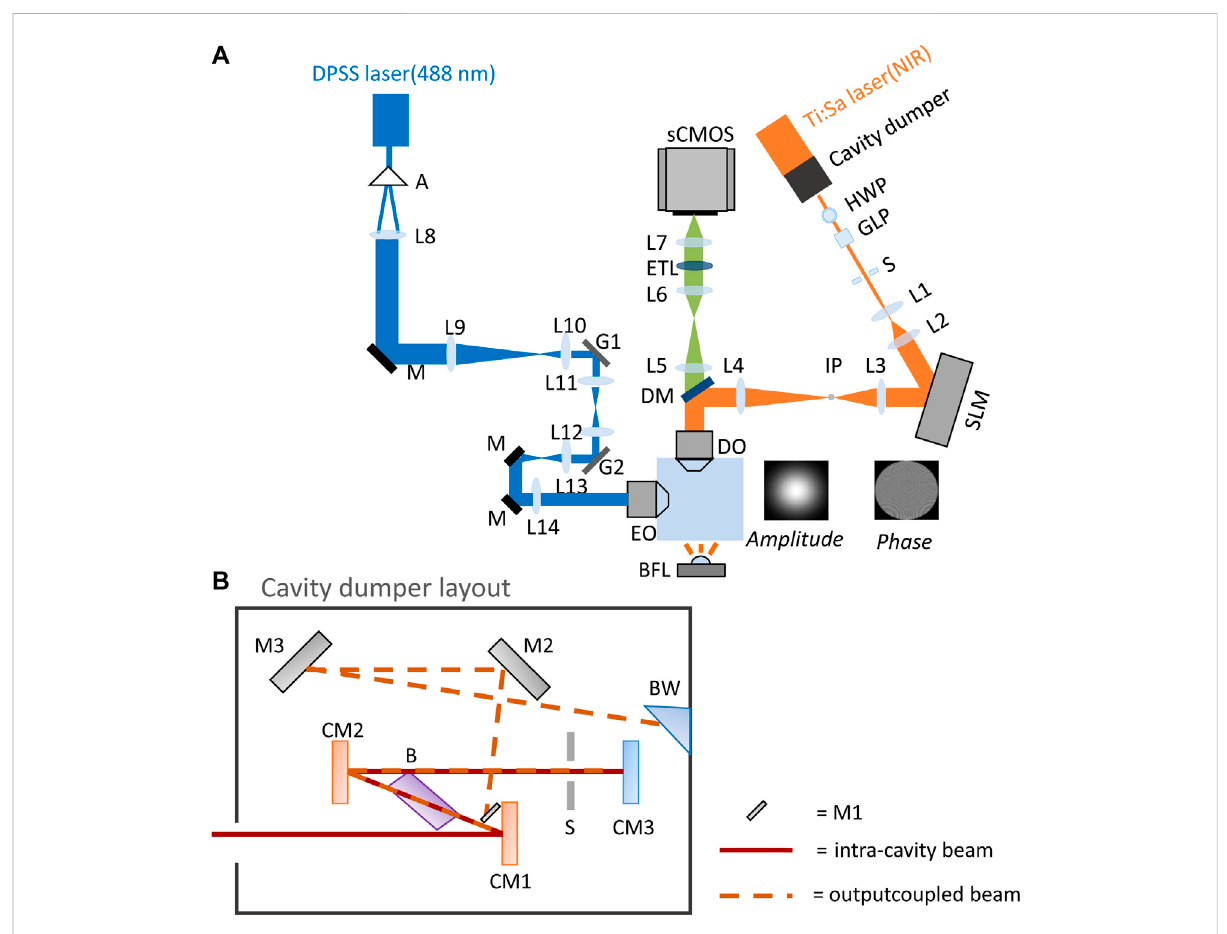
FIGURE 1 Optical setup. (A) Optical layout of the 2P-CGH module coupled to a light sheet microscope. Blue path: light sheet microscope; orange path: 2P-CGH module; green path: common fl uorescence detection path. Not to scale. (B) Cavity dumping layout, not to scale. Red line: intra-cavity beam, dashed orange line: dumped beam. The intra-cavity beam is focused by the focusing mirror (CM1) into the Bragg cell (B) placed at Brewster ’ s angle.TheRFpulseappliedtotheBraggcellde fl ectspartofthebeaminthe fi rstorderofdiffraction(dashedorangeline).Bothundiffractedand diffracted beam are collimated again by the collimating mirror (CM2) and retrore fl ected by the end mirror (CM3), passing through the slit (S). Then, both beams pass the Bragg cell a second time. The undiffracted part of the beam is retrore fl ected into the Ti:Sapphire cavity while the diffracted portion is re fl ected by mirror M1 towards mirrors M2 and M3. Finally the selected pulse leaves the cavity through the Brewster window